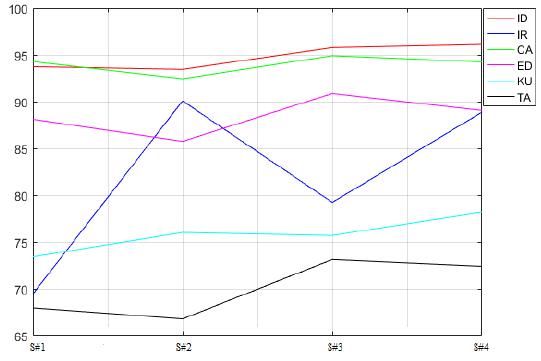
Figure 9 .Trend of OA for CD methods in Data 1